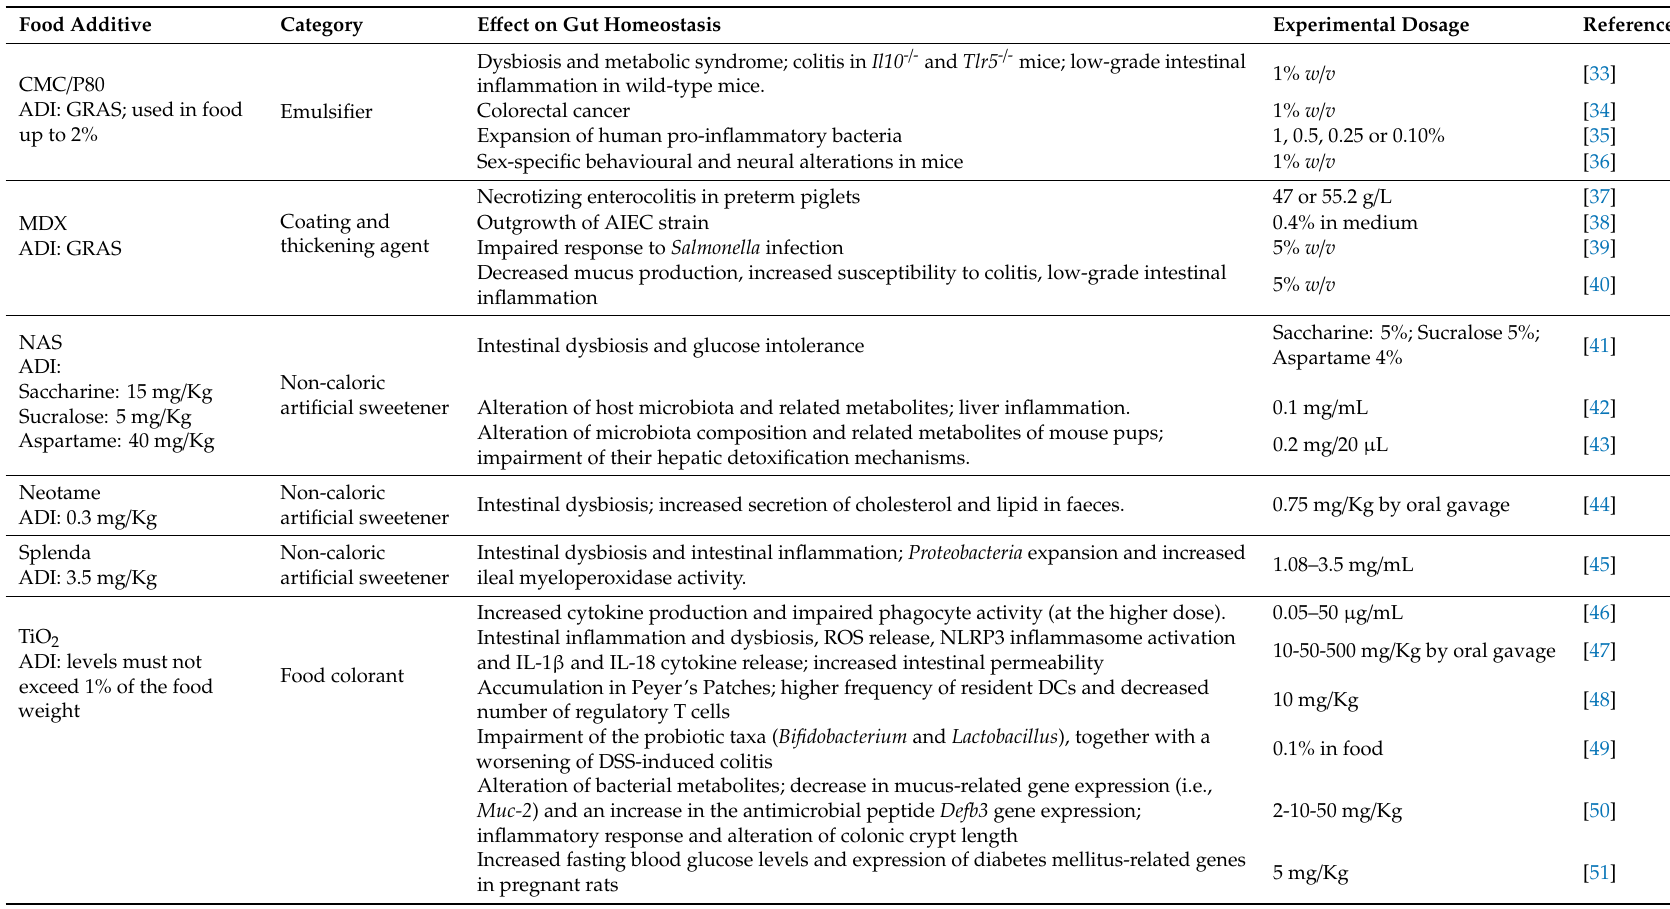
Table 1. E ff ects of food additives on gut homeostasis. All the indicated substances were used in pre-clinical studies and administered orally. All the food additives were dissolved in drinking water unless otherwise indicated in the “Experimental